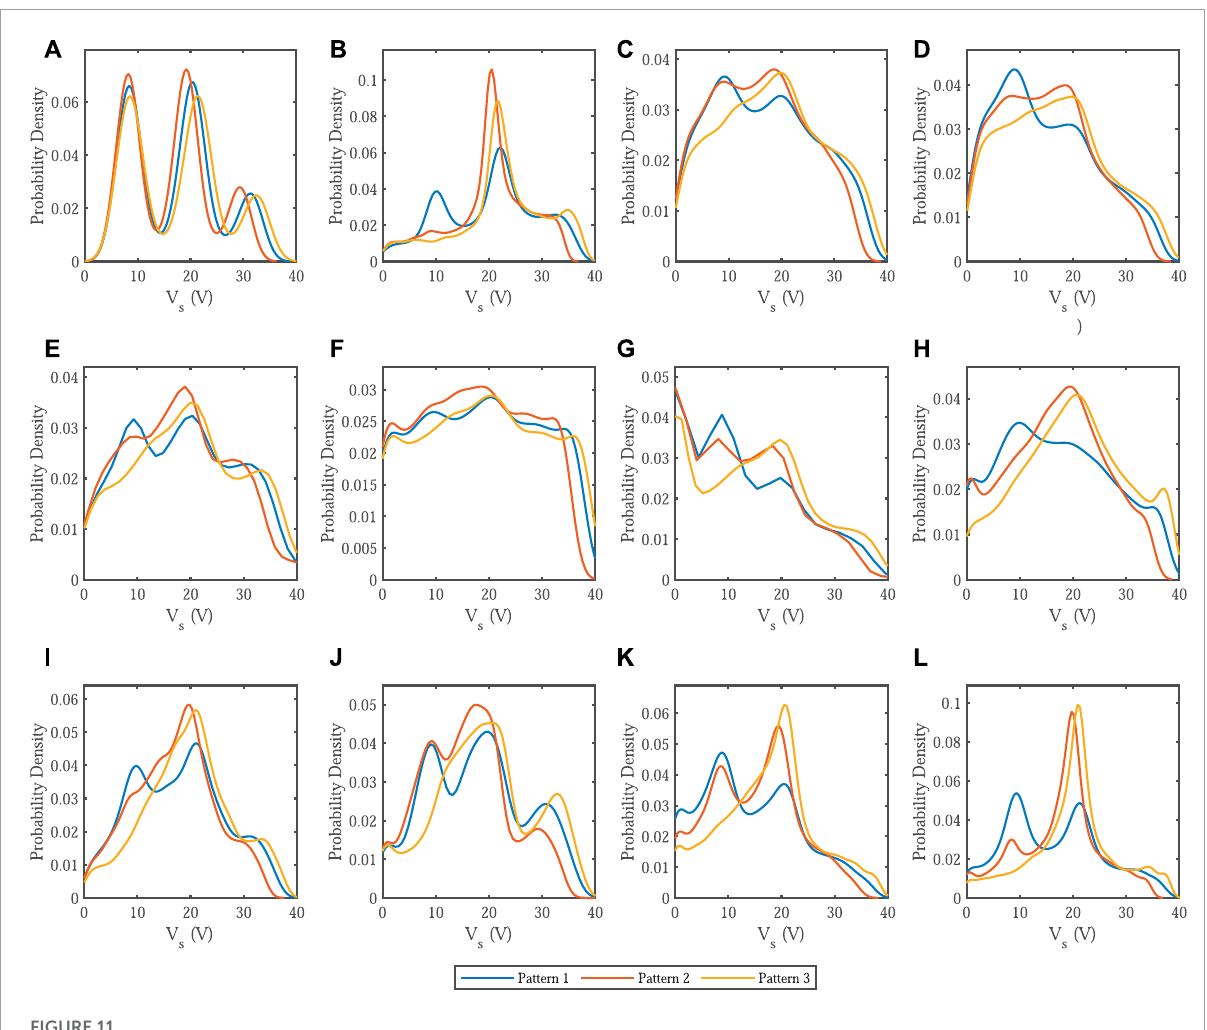
FIGURE 11 Distribution of the voltage sampling points for the algorithms in the test of three JH-10 modules in series connection with random PSCs: (A) VVS; (B) VS; (C) ABCA; (D) CS; (E) FAO; (F) FPO; (G) HHO; (H) Jaya; (I) PSO; (J) SFLA; (K) TLBO; (L) WCA.